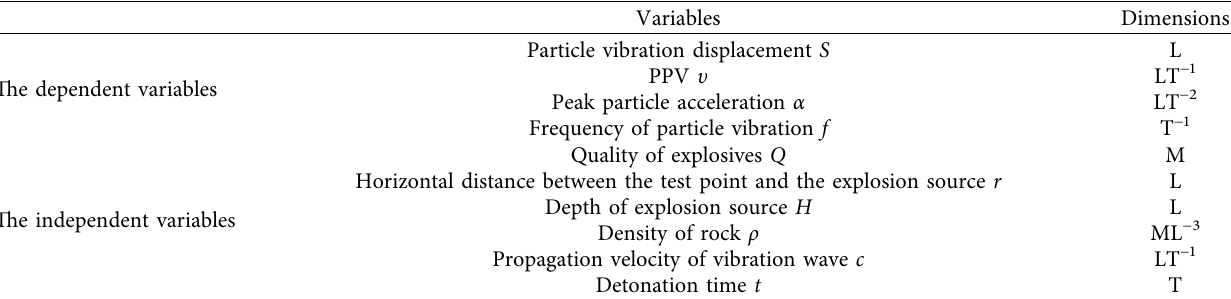
Table 8: Physical quantities involved in blasting vibration velocity in silt-rock